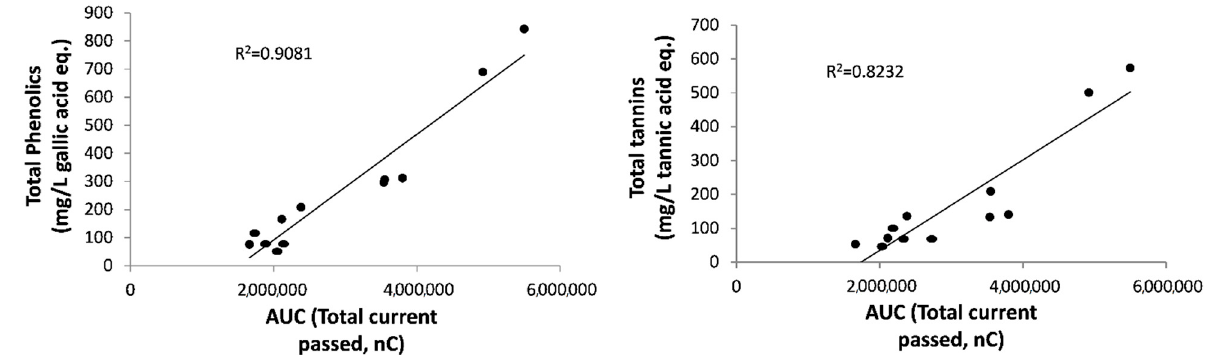
Figure 2. Correlations between electrochemical features and total phenolics and total tannins of different oak extracts.